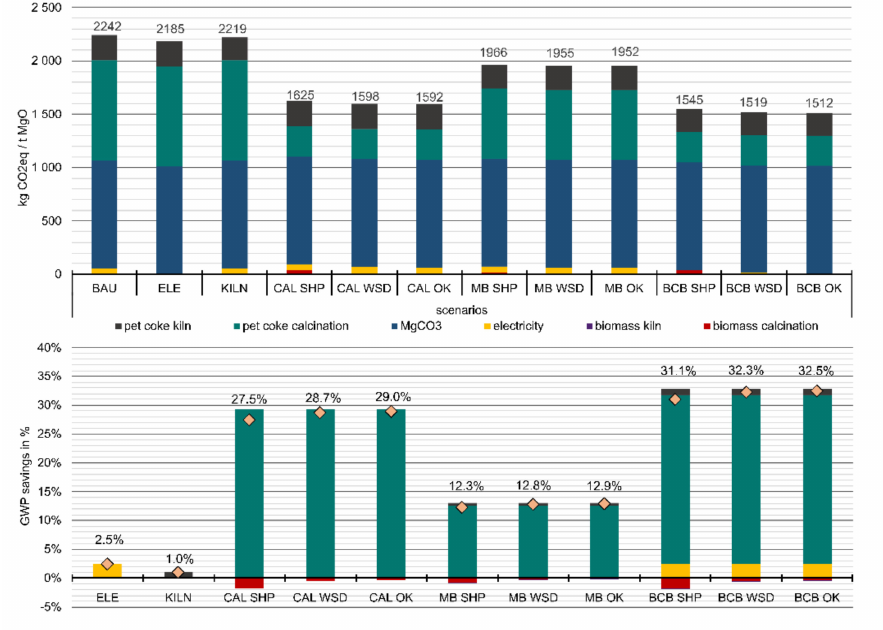
Figure 9. GWP of 1 ton of CCM MgO ( upper figure) and relative GWP savings against business-as- usual scenario ( lower figure) based on scenario description of Table